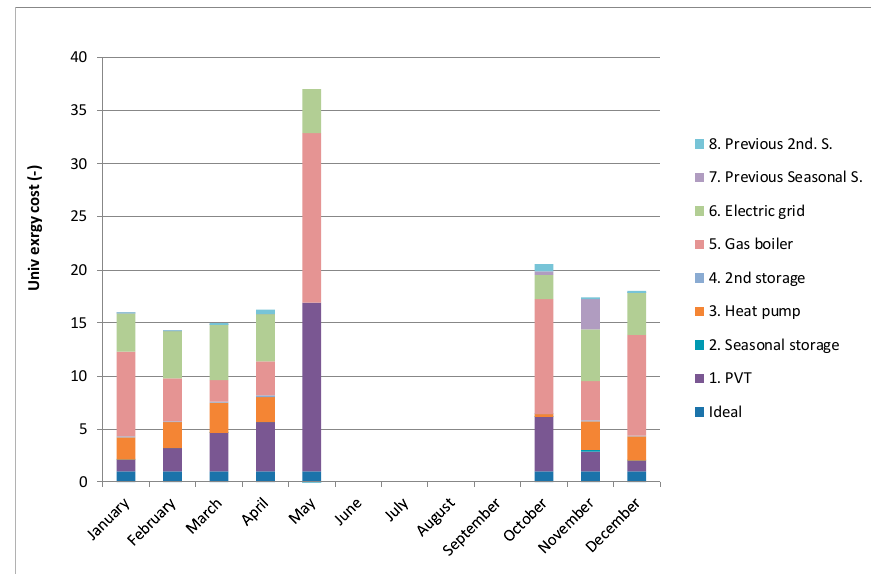
Figure 22. Heat pump: Cost formation by source.